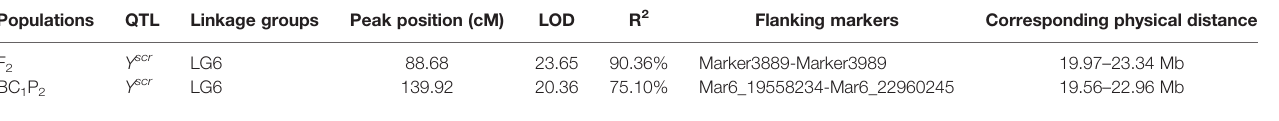
TABLE 1 | Quantitative trait loci (QTL) mapping for fl esh color in R\qtlbim, which analyzes the QTL model for binary traits.